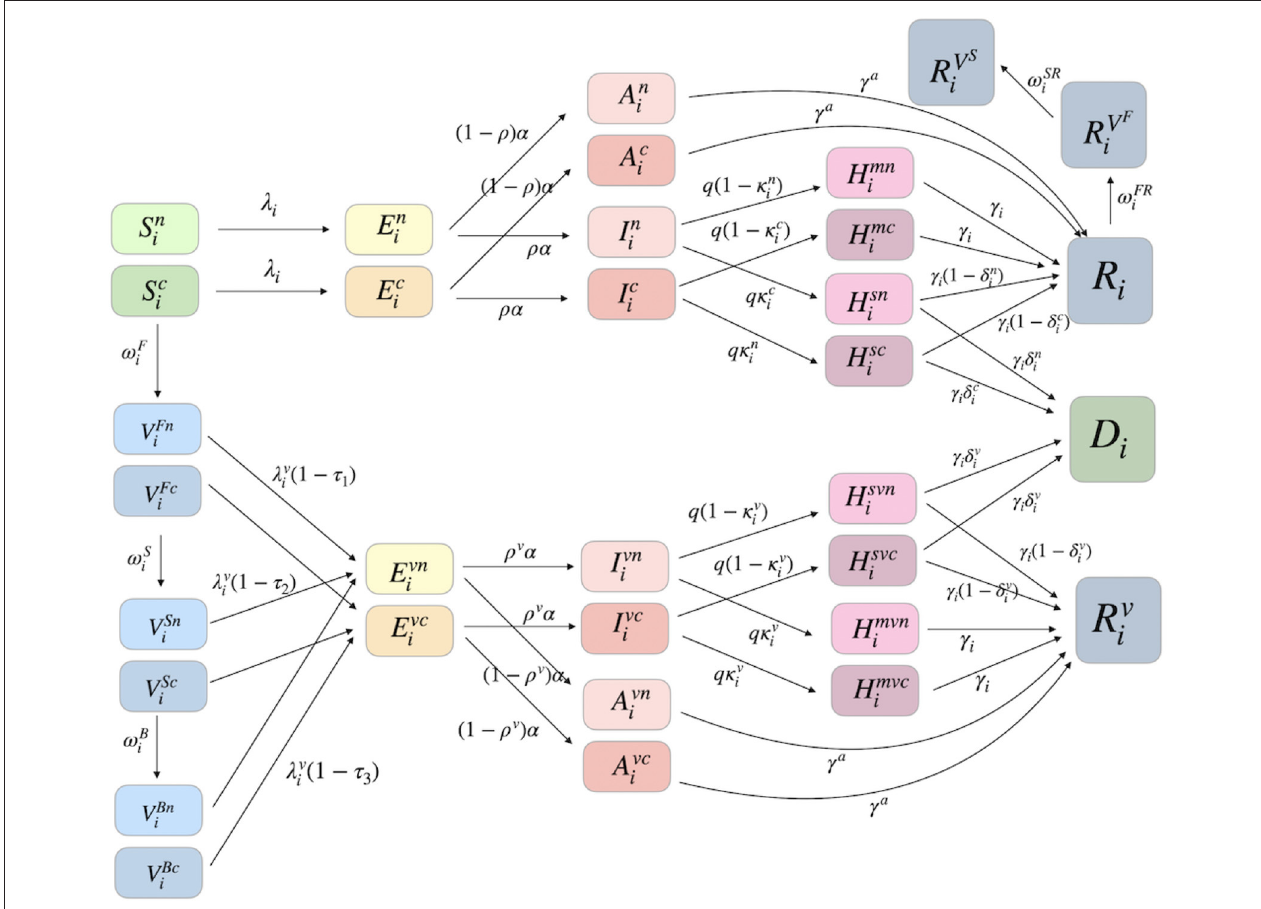
FIGURE 2 | A schematic diagram of our age-specific mathematical model is shown in the presence of the first, second, and booster vaccinated classes. Furthermore, each age group is divided into two groups: the one under normal condition without comorbidities and the other one with comorbidities.